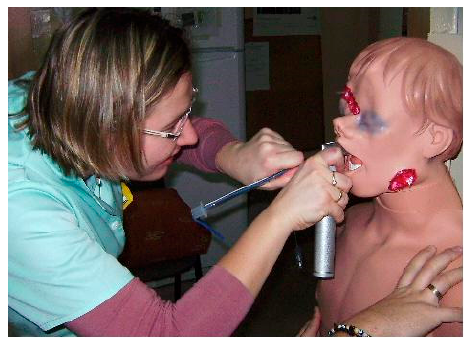
Figure 3. Intubation of a trauma manikin in a sitting position (Author`s own material).